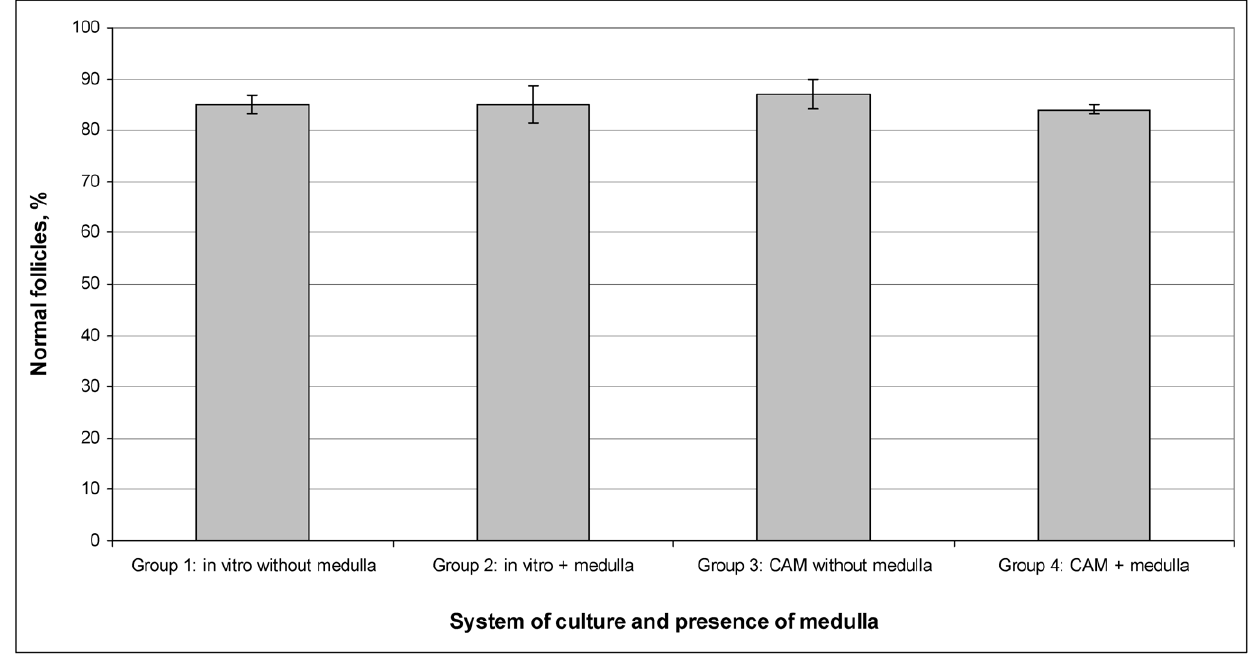
doi:10.1371/journal.pone.0032549.g003